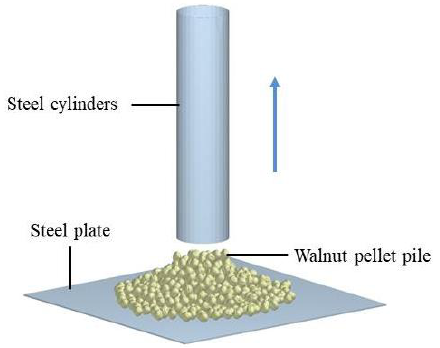
Figure 7. DEM simulation model of cylinder lifting.